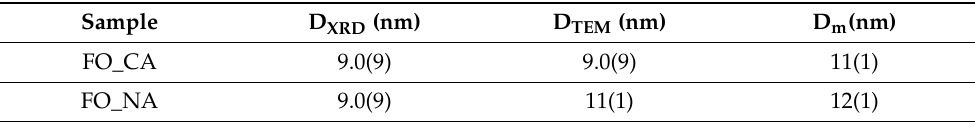
Figure 1. XRD patterns of samples synthesized in controlled atmosphere, nitrogen (FO-CA, solid line) and in normal atmosphere, air (FO-NA, dashed line). Table 1. Crystallites size from X-ray Diffraction (D XRD ), particle diameter from TEM (D TEM ) and magnetic diameter (D m ) for FO-CA and FO-NA nanoparticles, uncertainties on the last digit are given in parentheses.